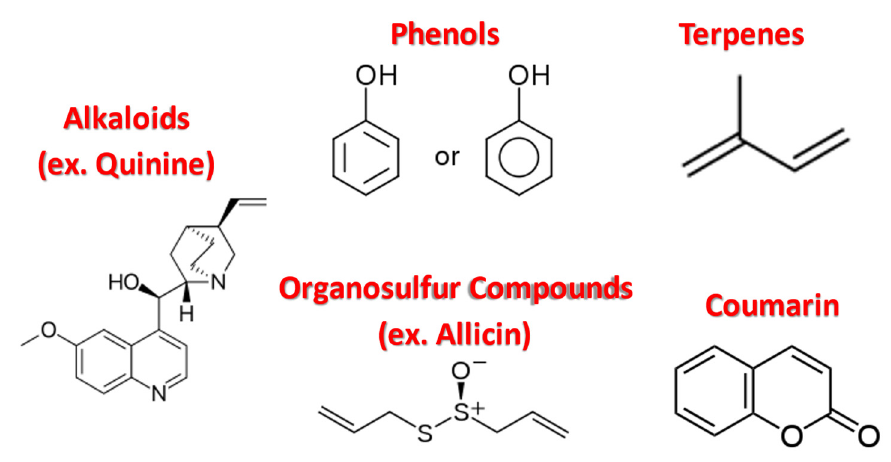
Figure 1. Structures of major phytochemical families.